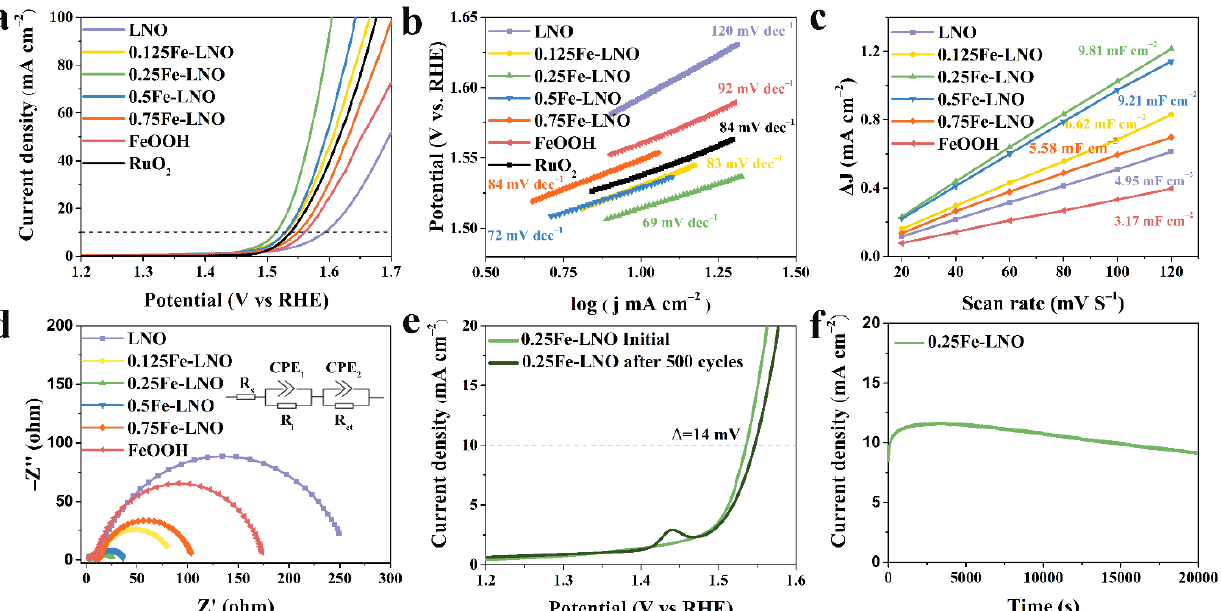
Figure 4. ( a ) LSV of LNO, FeOOH and Fe-LNO samples. ( b ) The corresponding Tafel plots. ( c ) Linear fits of half capacitive currents versus scan rates for the extraction of the double-layer capacitances. ( d ) Nyquist plots. The inset of ( d ) is the equivalent circuit diagram. ( e ) The initial polarization curves and the 500th cycles of 0.25Fe ‐ LNO. ( f ) The chronoamperometric curves of 0.25Fe ‐ LNO.